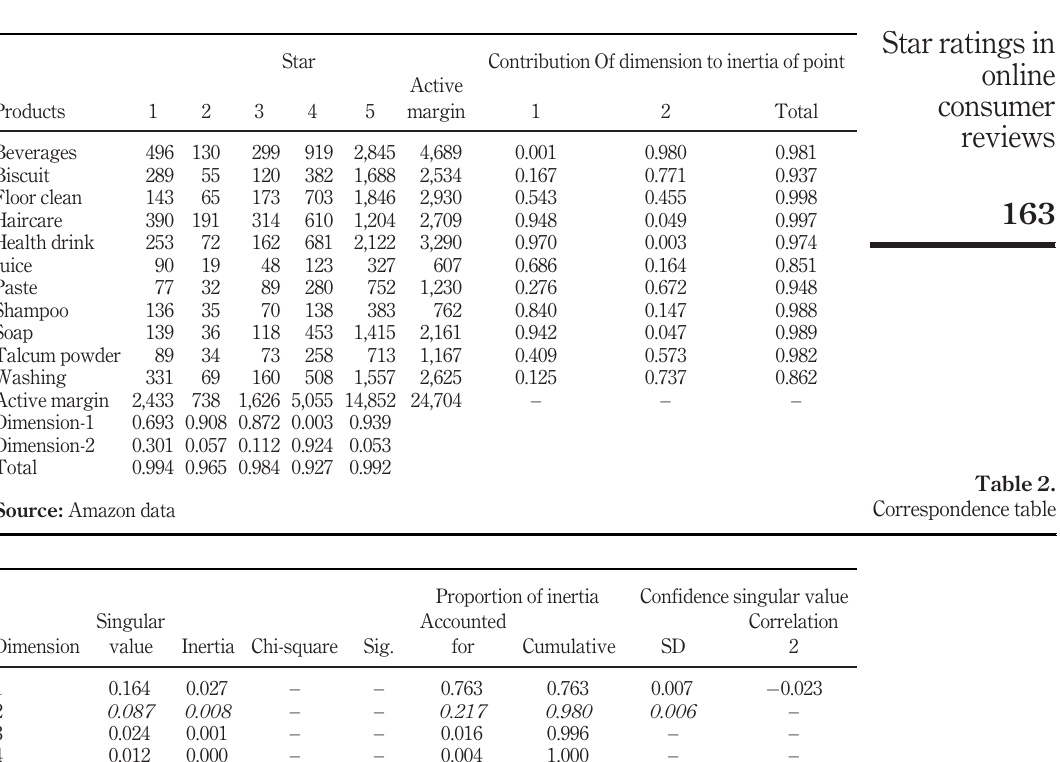
Table 3. Fitness